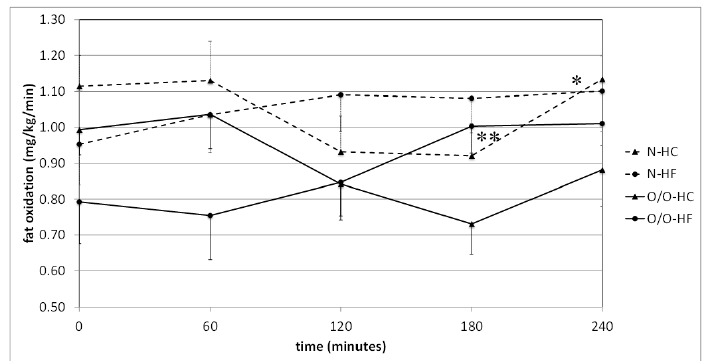
Figure 7. Fat oxidation (mg/kg/min) in people with normal body weight (N, the broken line) and overweight/obese people (O/O, the solid line) in fasting state (time 0 min) and after consumption (time 60–240 min) of a high-carbohydrate meal (HC) and a high-fat meal (HF). The results are presented as mean values ± SE. The comparison between study groups N and O/O * p < 0.05; the comparison between meals HC and HF ** p < 0.05.